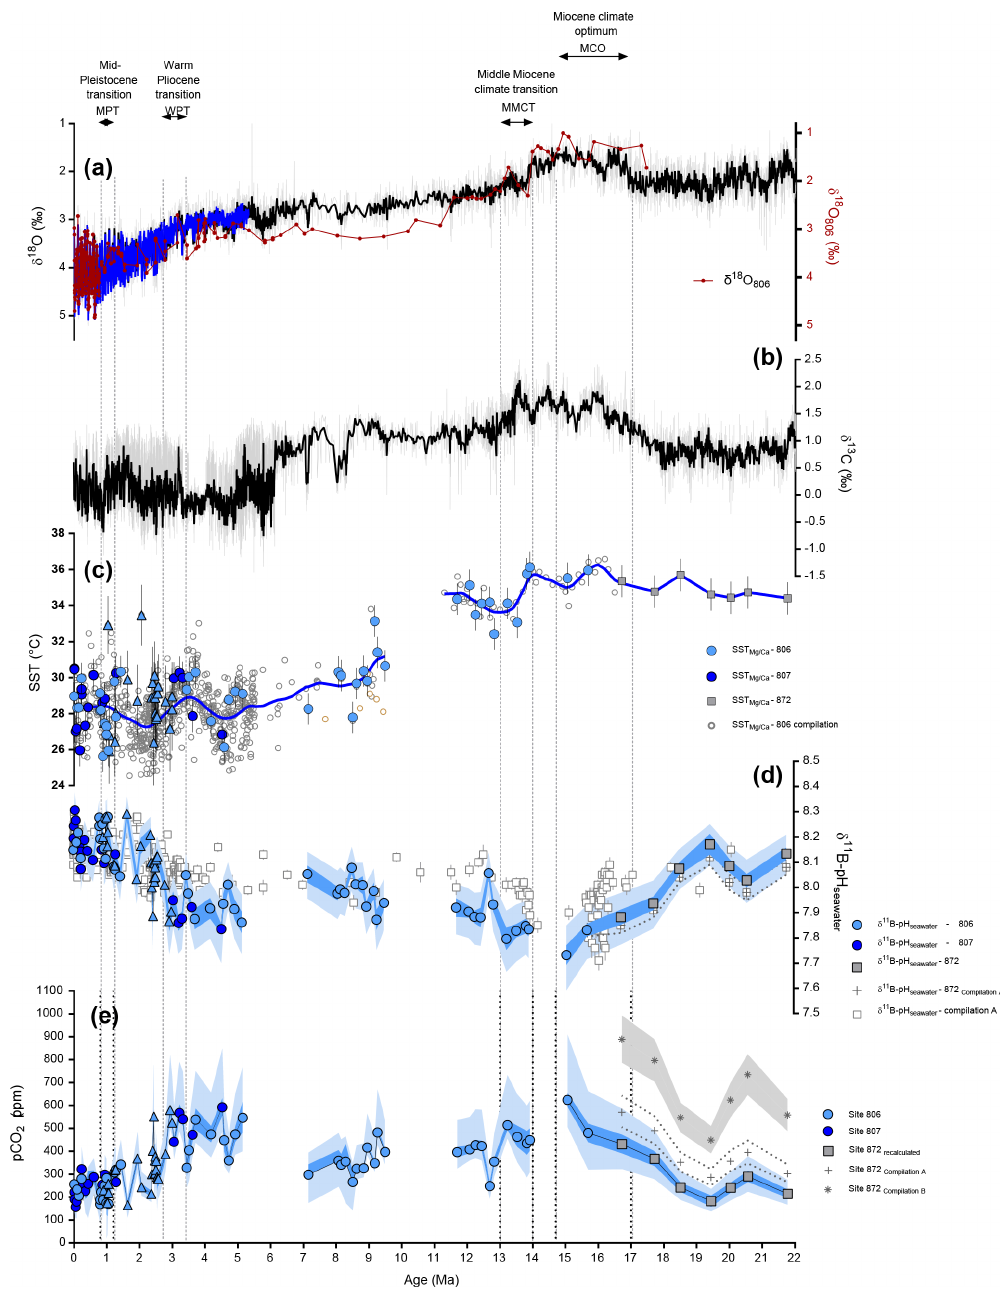
Figure 7. Proxy data for the past 22 million years in the Western Equatorial Pacific compared to benthic oxygen isotope data. (a) Benthic δ 18 O (blue line – stack from Lisiecki and Raymo, 2005; black line – compilation from Zachos et al., 2008). (b) Benthic δ 13 C (black line – compilation from Zachos et al., 2008). (c) – (e) Color indicates the site (filled light blue = 806, filled dark blue = 807), symbols represent the species (circle = T. sacculifer and triangle = G. ruber ), filled grey squares are recalculated data based on Sosdian et al. (2018) at site 872. (c) SST reconstructed at ODP Sites 806 and 807 using Mg / Ca ratios (see Supplement for reconstruction details), open symbols are reconstructed temperatures based on literature Mg / Ca at site 806 (see text or Fig. 4). (d) Seawater pH reconstructed from δ 11 B of T. sacculifer and G. ruber using δ 11 B seawater from Greenop et al. (2017) (refer to text and Supplement for calculations, this study), open squares (compilation A) represent data from the CO 2 compilation of Sosdian et al. (2018), and open triangles (compilation B) are compilation data from Rae et al. (2021). (e) Reconstructed p CO 2 (ppm) using boron-based pH and alkalinity from Caves et al. (2016), data presented are from this study. Propagated uncertainties are given by Eq. (S17) for the dark blue envelope, while the light blue envelope shows the uncertainties calculated based on Eq. (S16) (taking into account uncertainty in δ 11 B seawater ). Crosses are original p CO 2 values calculated in Sosdian et al. (2018) at Site 872; asterisks are recalculated p CO 2 values at Site 872 by Rae et al. (2021).